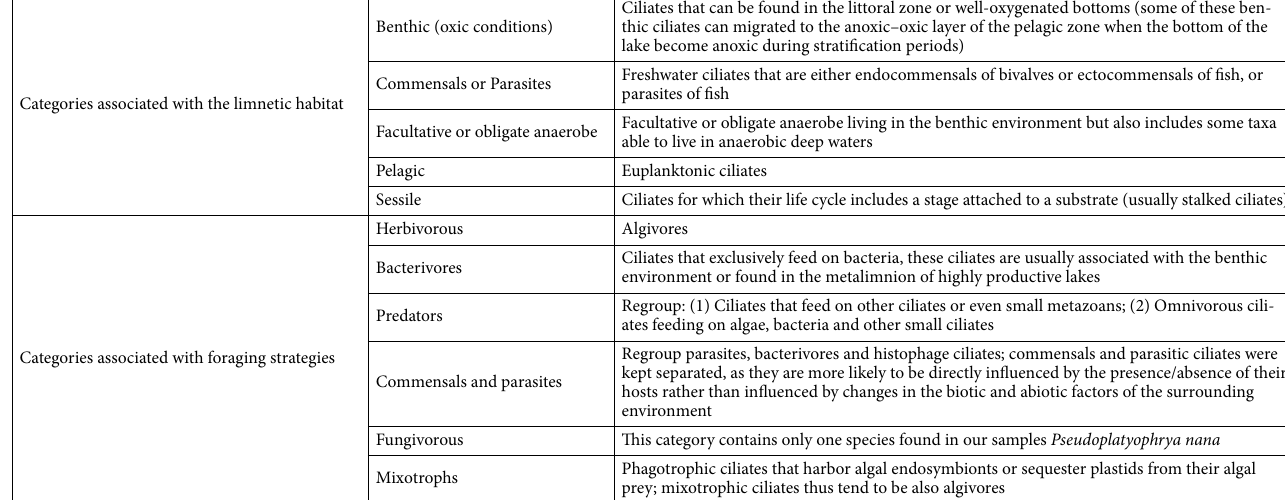
Table 1. Description of the ciliates functional traits